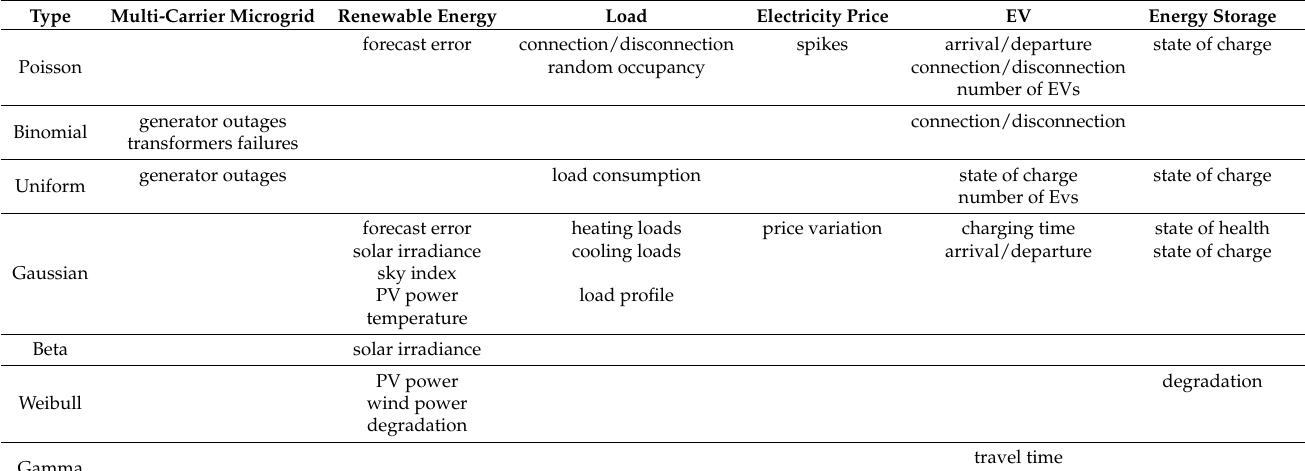
Table 3. Main probability distribution functions in microgrid